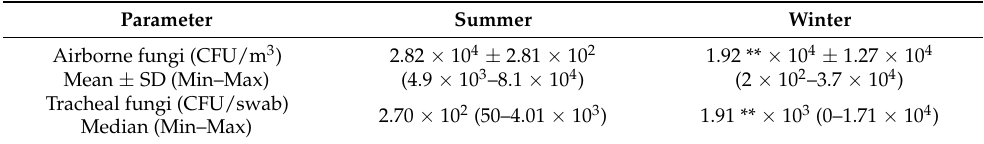
Table 3. Total fungal count in house air and broiler trachea during five-week fattening in summer and winter.